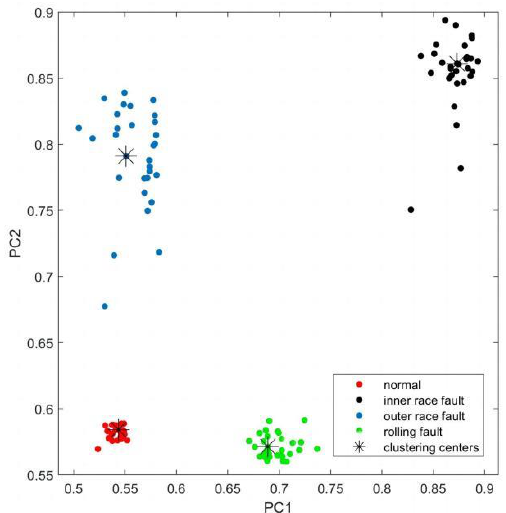
Figure 9. Result of density peak clustering. Table 4. Coordinates of four cluster